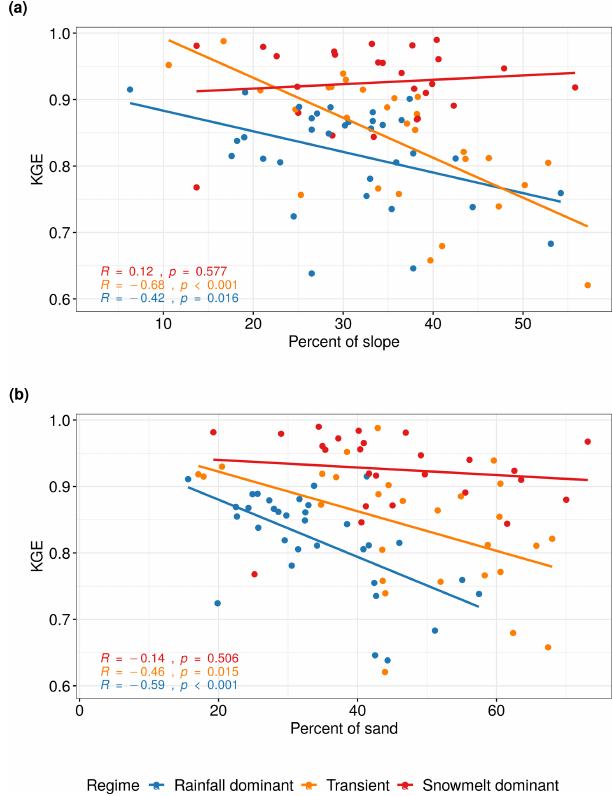
Figure 11. KGE scores plotted against (a) the average percent of slope and (b) the average percent of sand in soil at each watershed. Best-fit lines were determined using simple linear regression. Pear- son correlation coefficients were computed with associated signifi- cance.